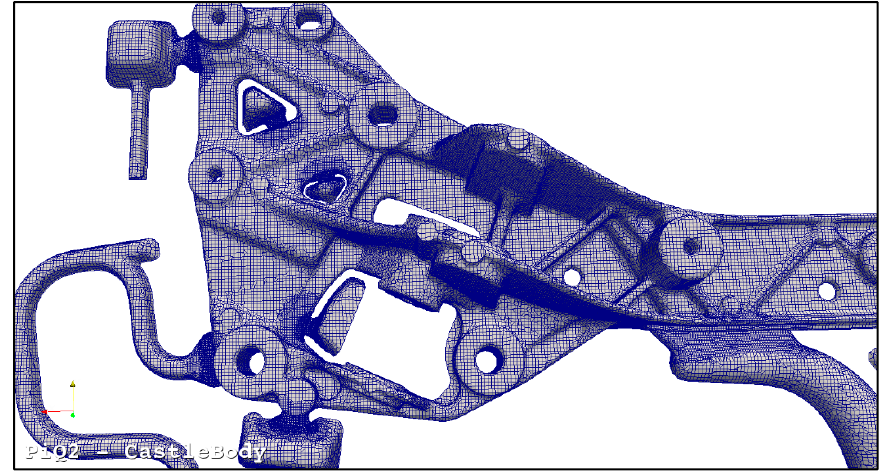
Figure 4. Local mesh refinement.